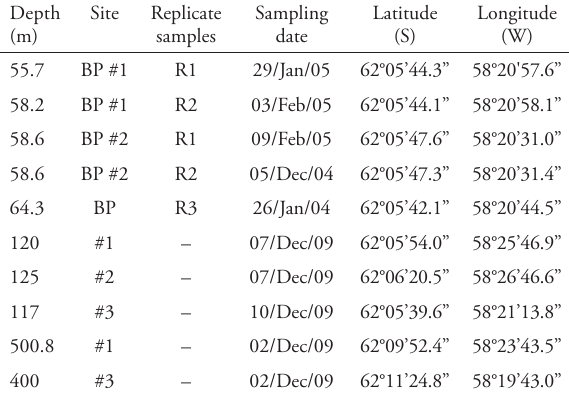
Table 1. Study area and their sites and geographic coordinates containing Tanaopsis bamberi sp. nov. and Tanaopsis brevicorpus sp. nov. BP: Botany